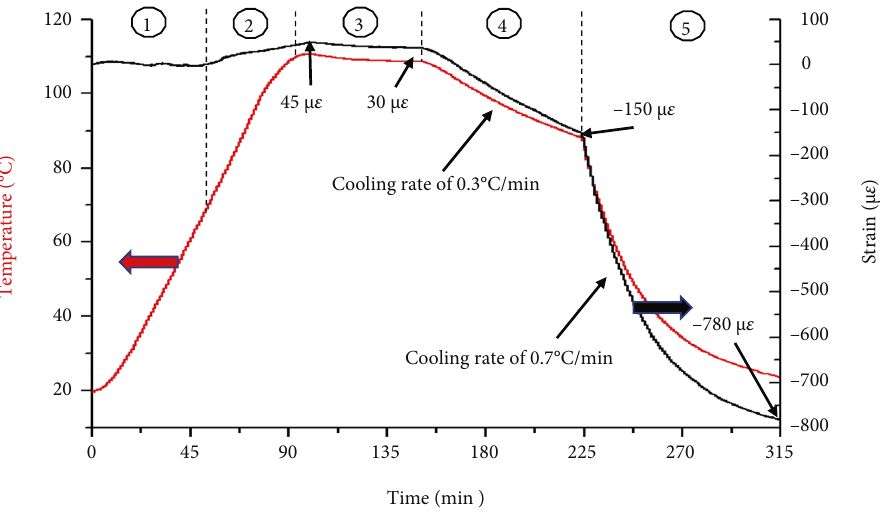
Figure 9: The temperature and strain history during the co-cure bonding process. Table 3: Comparison of the residual strains in the cooling phase obtained by the FBGSS and theoretical calculation (Equation (18) Cooling phase ( ° C)